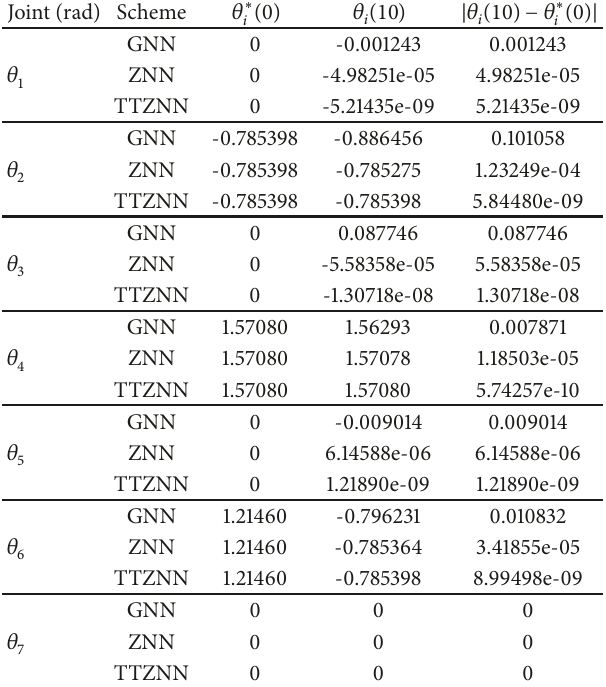
Table 3: Free joints of the manipulator PA10 synthesized with scheme (24) with different neural solutions Joint (rad)